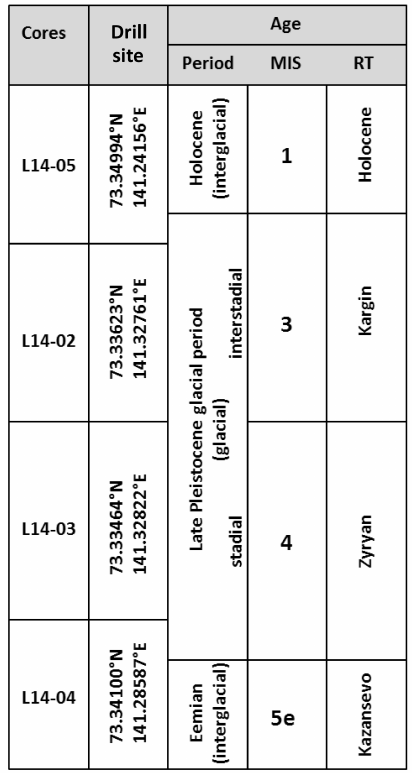
Table 1. Schematic overview of assigned ages of the core material drilled on Bol’shoy Lyakhovsky Island showing the different cores with their drilling positions in relation to different age periods (in- terval names, marine isotope stages (MIS) and Russian terminology (RT) for the respective time periods). The age assignment is based on information obtained from Andreev et al. (2004, 2009) and Wet- terich et al. (2009,